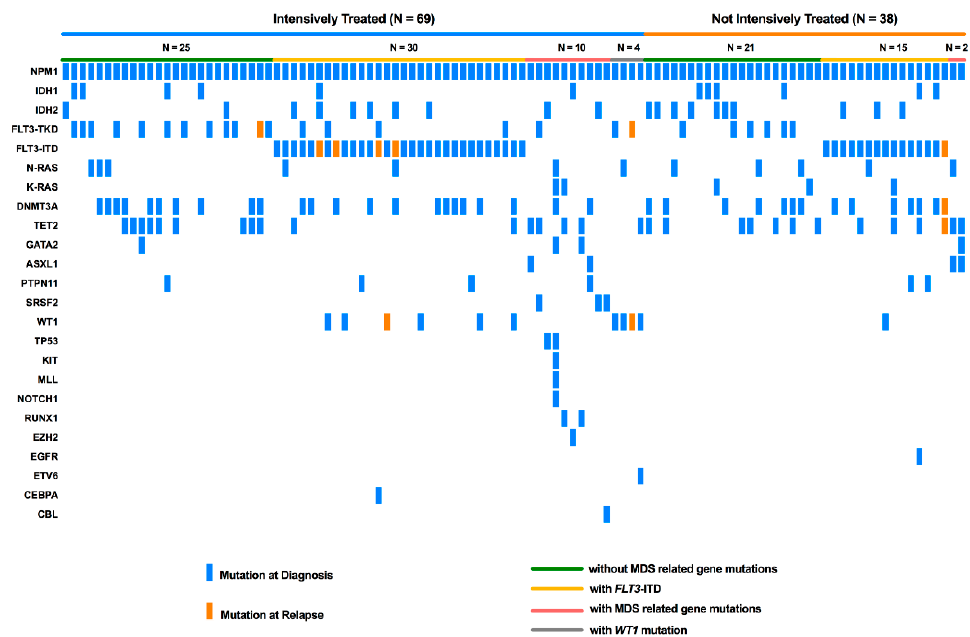
Figure 1. Mutational landscape of 107 cases of NPM1 mutated AML. Mutations of genes acquired at relapse are highlighted in orange and those at diagnosis in blue. Each column represents a patient. Table 1. Summary of clinicopathological features of the total study cohort. Table 2. Comparison between different risk groups of patients treated with intensive